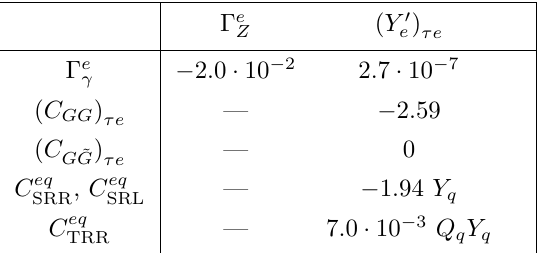
Table 22 . The Wilson coefficients of dipole, gluonic, scalar, and tensor operators at µ = 2 GeV induced by a Z dipole or a CLFV Yukawa through operator mixing. The Yukawa contribution to Γ e does not include the numerically larger effects from top quarks and weak bosons, given in γ eq. (A.46). q denotes a light quark, q ∈ { u, d, s } , and the quark Yukawa couplings Y at the scale µ